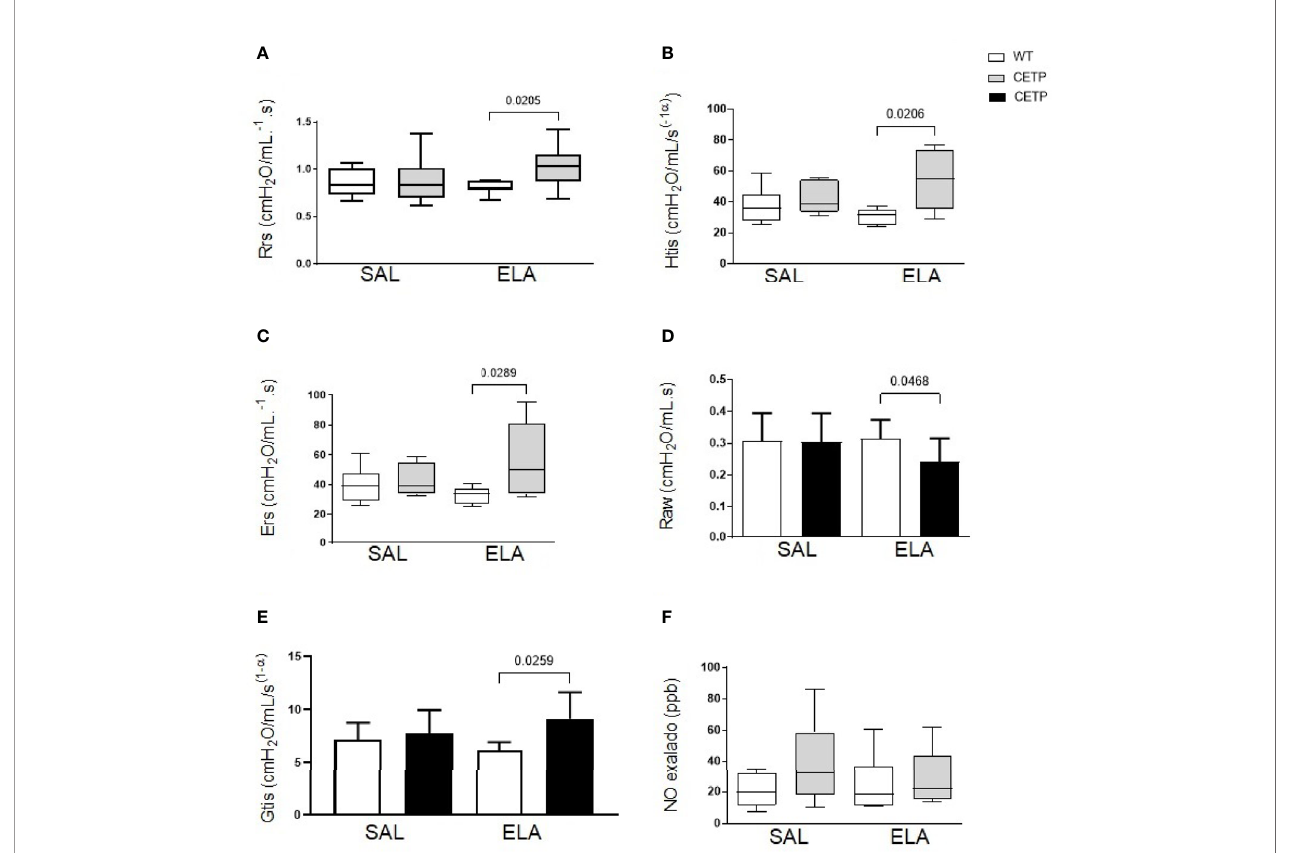
FIGURE 9 | Lung mechanics in WT and huCETP mice after elastase-induced emphysema (ELA), or saline (SAL). (A) Respiratory system resistance (Rrs); (B) Tissue elastance (Htis); (C) Respiratory system elastance (Ers); (D) Airway resistance (RAW). (E) Lung tissue resistance (Gtis); (F) Exhaled nitric oxide. Values expressed as median and percentiles 25 and 75 were analyzed by Kruskal – Wallis test with original FDR method of Benjamini and Hochberg post-test. Values were expressed as mean and standard deviation analyzed by ANOVA with two-stage linear step-up procedure of Benjamini, Krieger, and Yekutieli post-test; (n = 8). P <